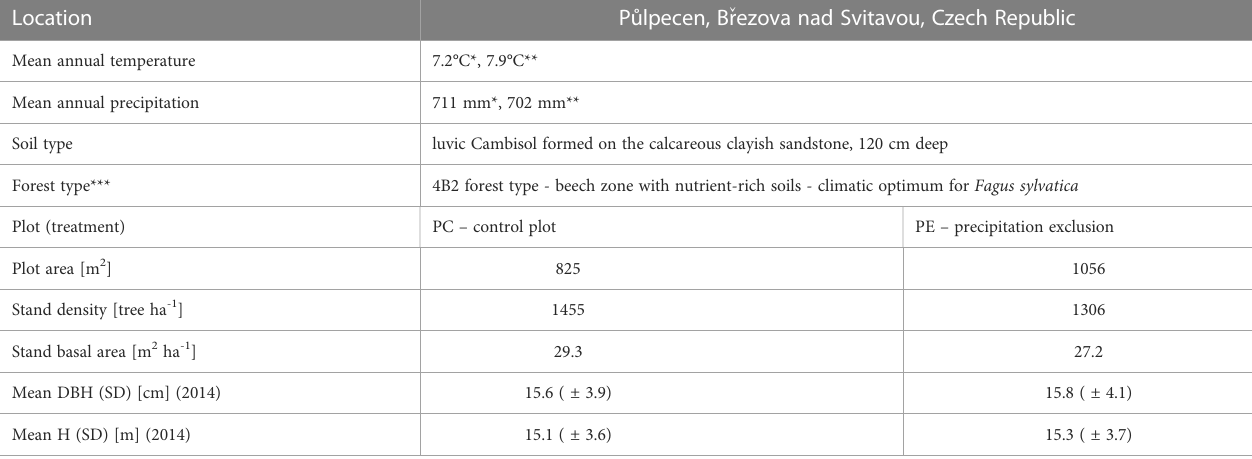
TABLE 1 Characteristics of studied sites with